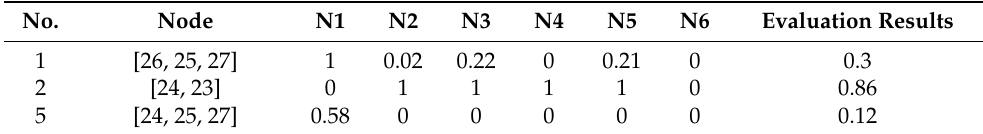
Table 5. Main network path and evaluation (110